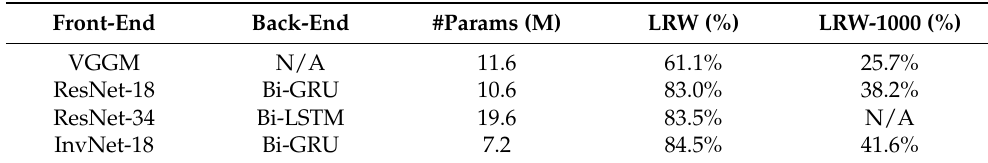
Table 3. Comparison results of InvNet-18 and other